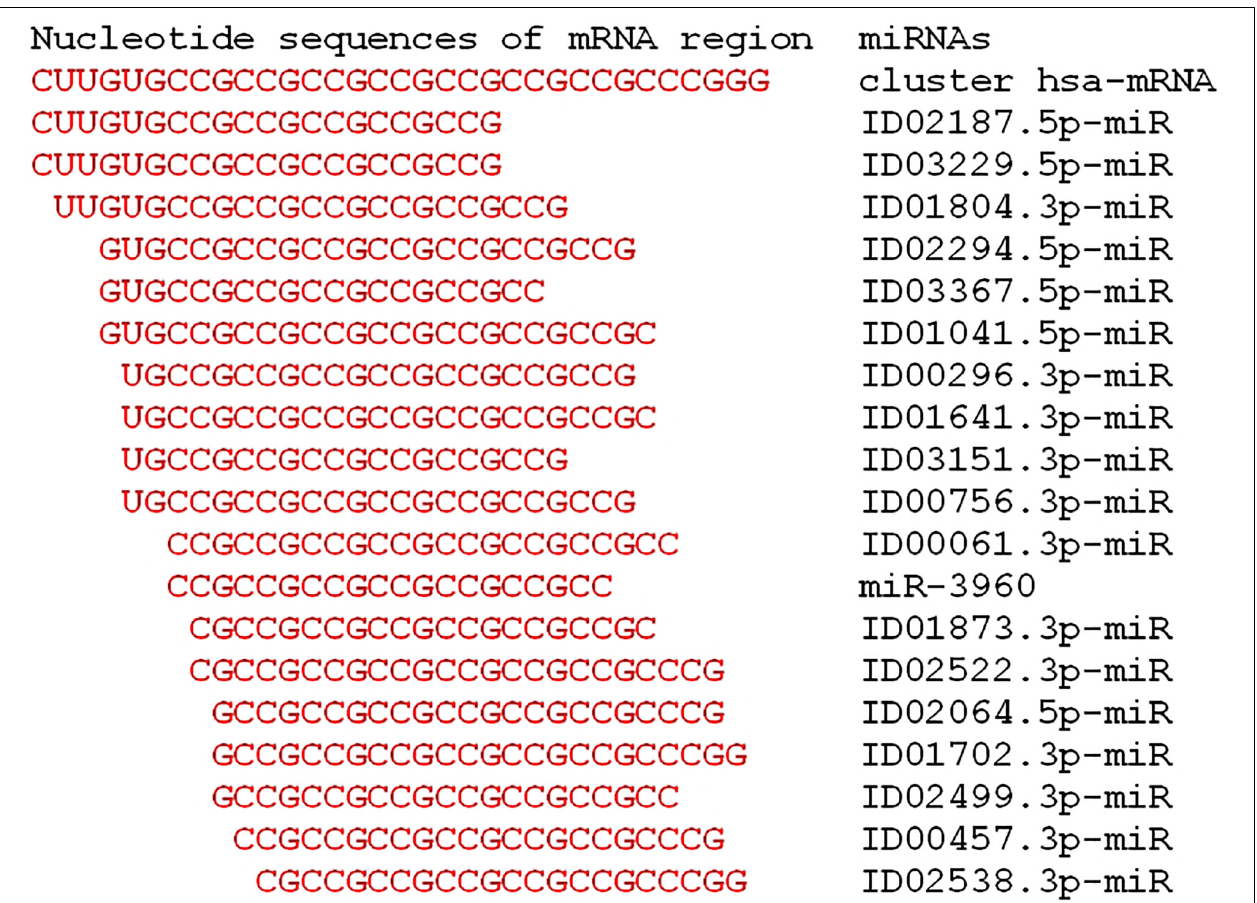
FIGURE 2 | Schemes of the location of miRNAs binding sites in the cluster located in the 5 (cid:48) UTR of the mRNA of the candidate hsa- GSK3B gene of Parkinson’s disease.